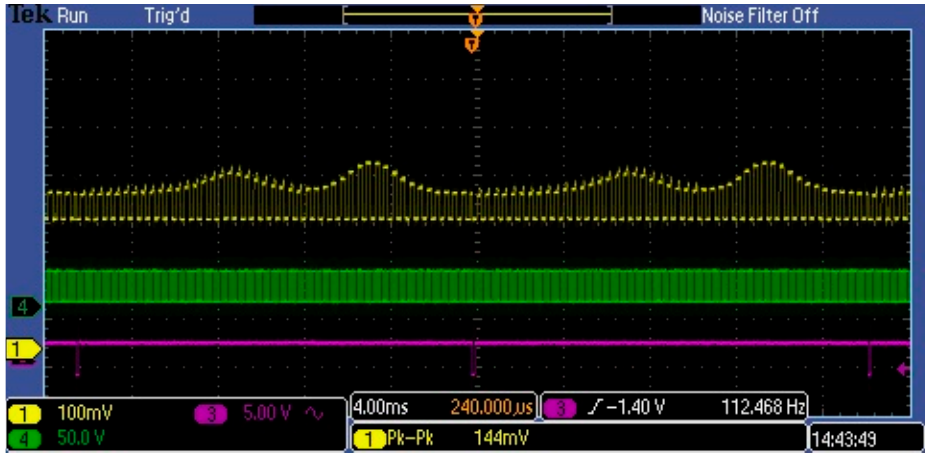
Figure 9. Captured MEMS signals: yellow is Video, green is Clock and purple is End of scan.